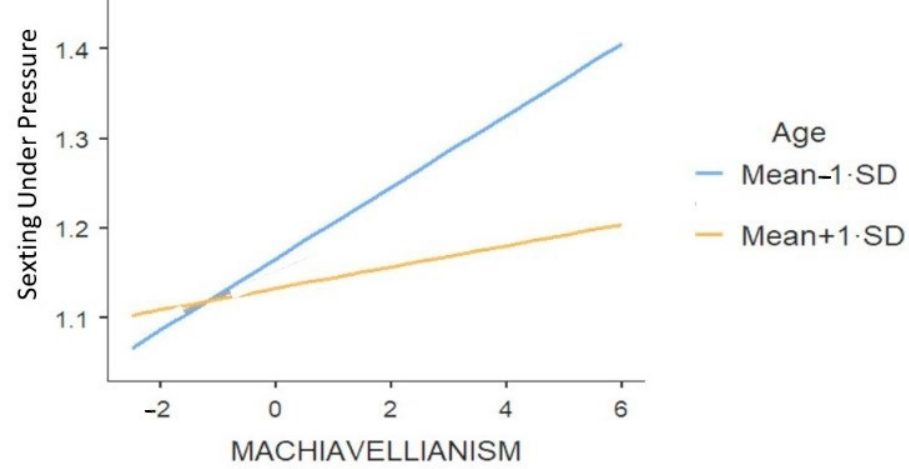
Figure 5. The effect of Machiavellianism on sexting under Pressure in Function of Age.